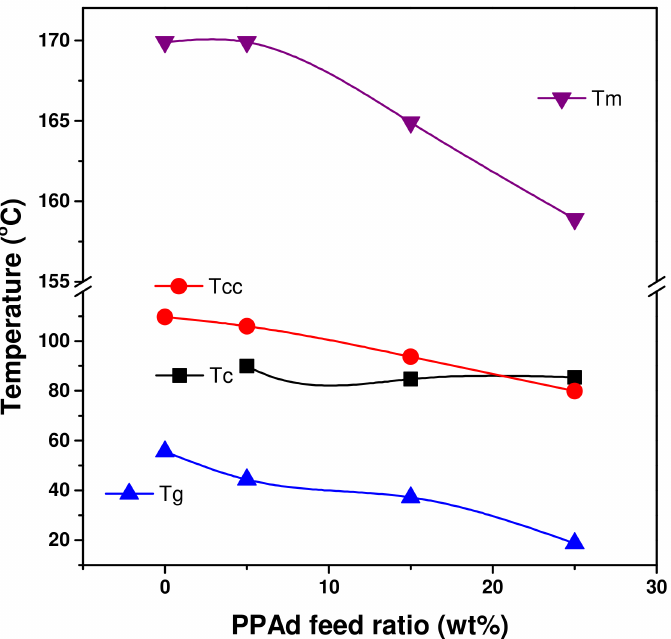
Figure 5. Effect of PPAd content on the thermal transition temperatures of PLA. (The lines are just guides for the